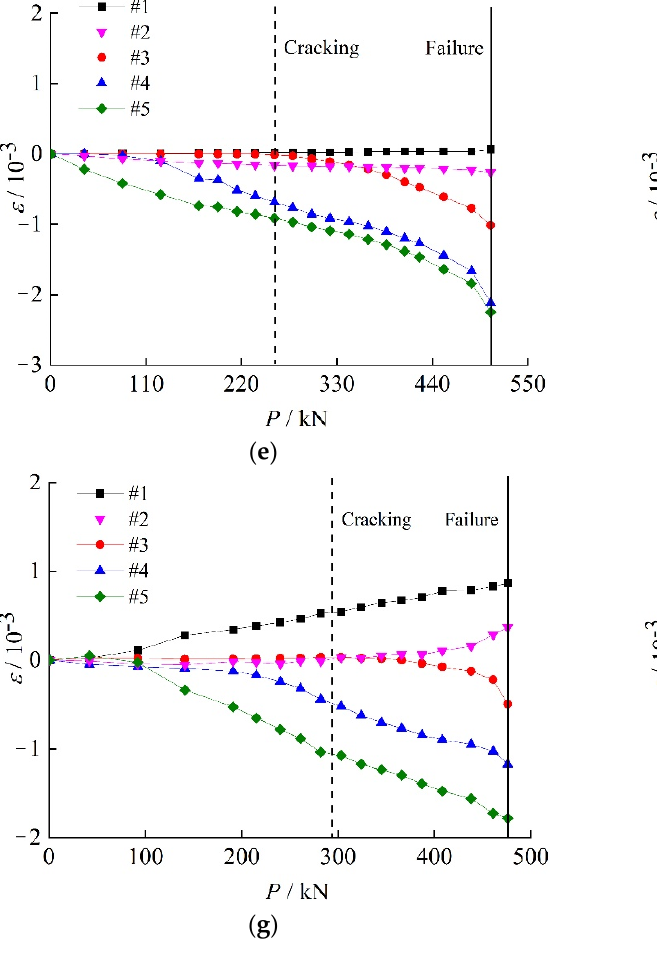
Figure 11. Strain development of specimens: ( a ) Clamp strain of P4B-CS-I, ( b ) Concrete strain of P4B-CS-I, ( c ) Clamp strain of P5A-CS-I, ( d ) Concrete strain of P5A-CS-I, ( e ) Clamp strain of P5C-CS-I, ( f ) Concrete strain of P5C-CS-I, ( g ) Clamp strain of P6A-CS-I, ( h ) Concrete strain of P6A-CS-I.